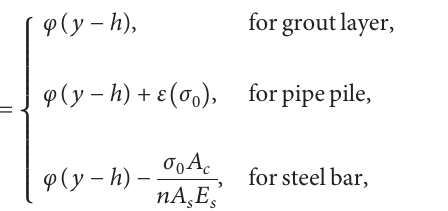
Figure 4: Cracking effect analysis: (a) force and deformation diagram of the pile; (b) cracks in the pile section; (c) deformation of the pile microsegment; (d) strain distribution in the grout layer; (e) strain distribution in concrete of the pipe